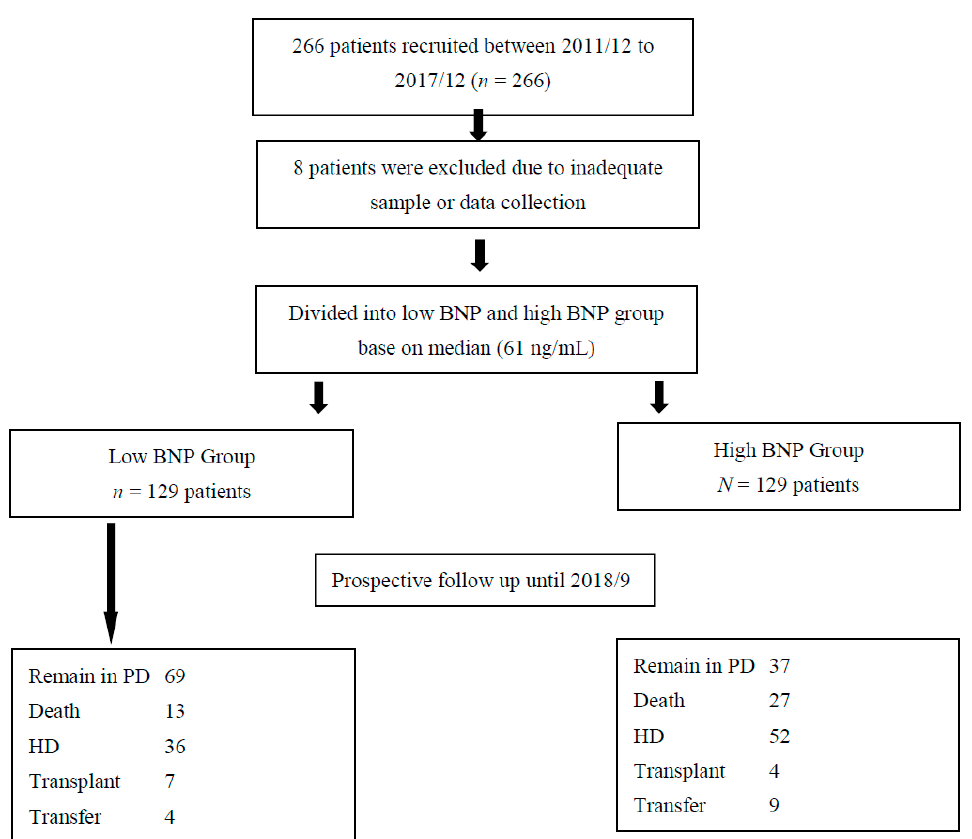
Figure 1. Flow chart of patient selection for this study. BNP, brain natriuretic peptide; HD, hemodialysis; PD, peritoneal dialysis.